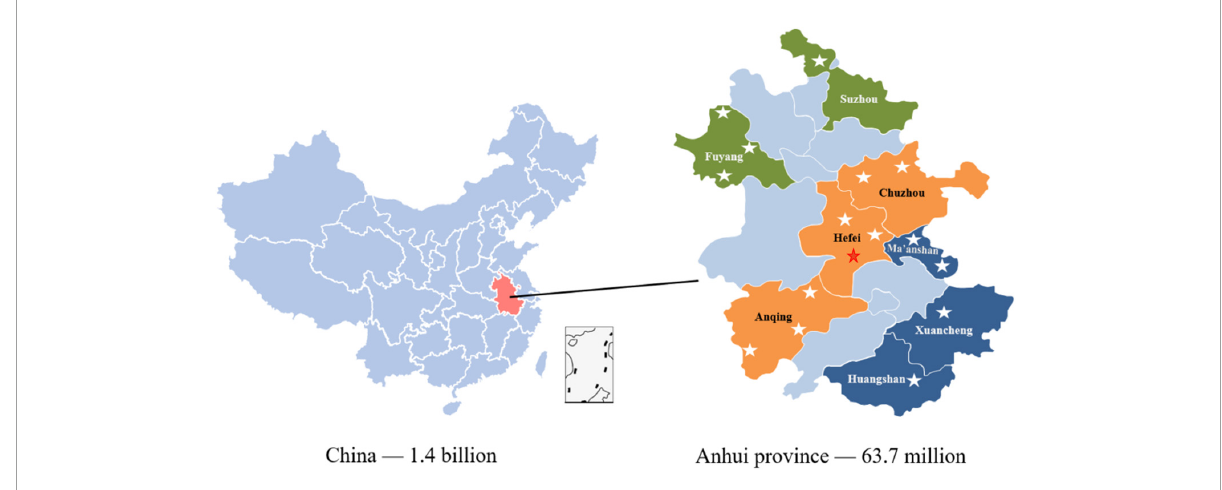
FIGURE1 Distribution of multi-center recruitment cities/countries.